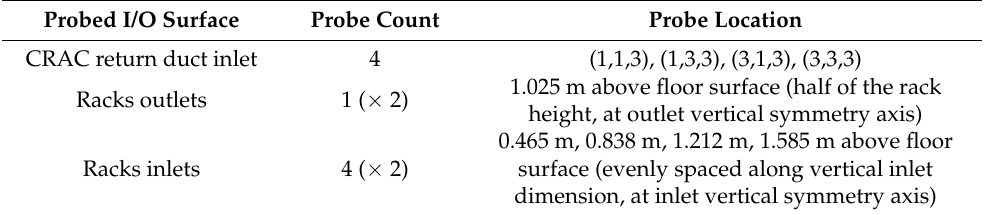
Table 2. List of temperature probes in virtual server room.